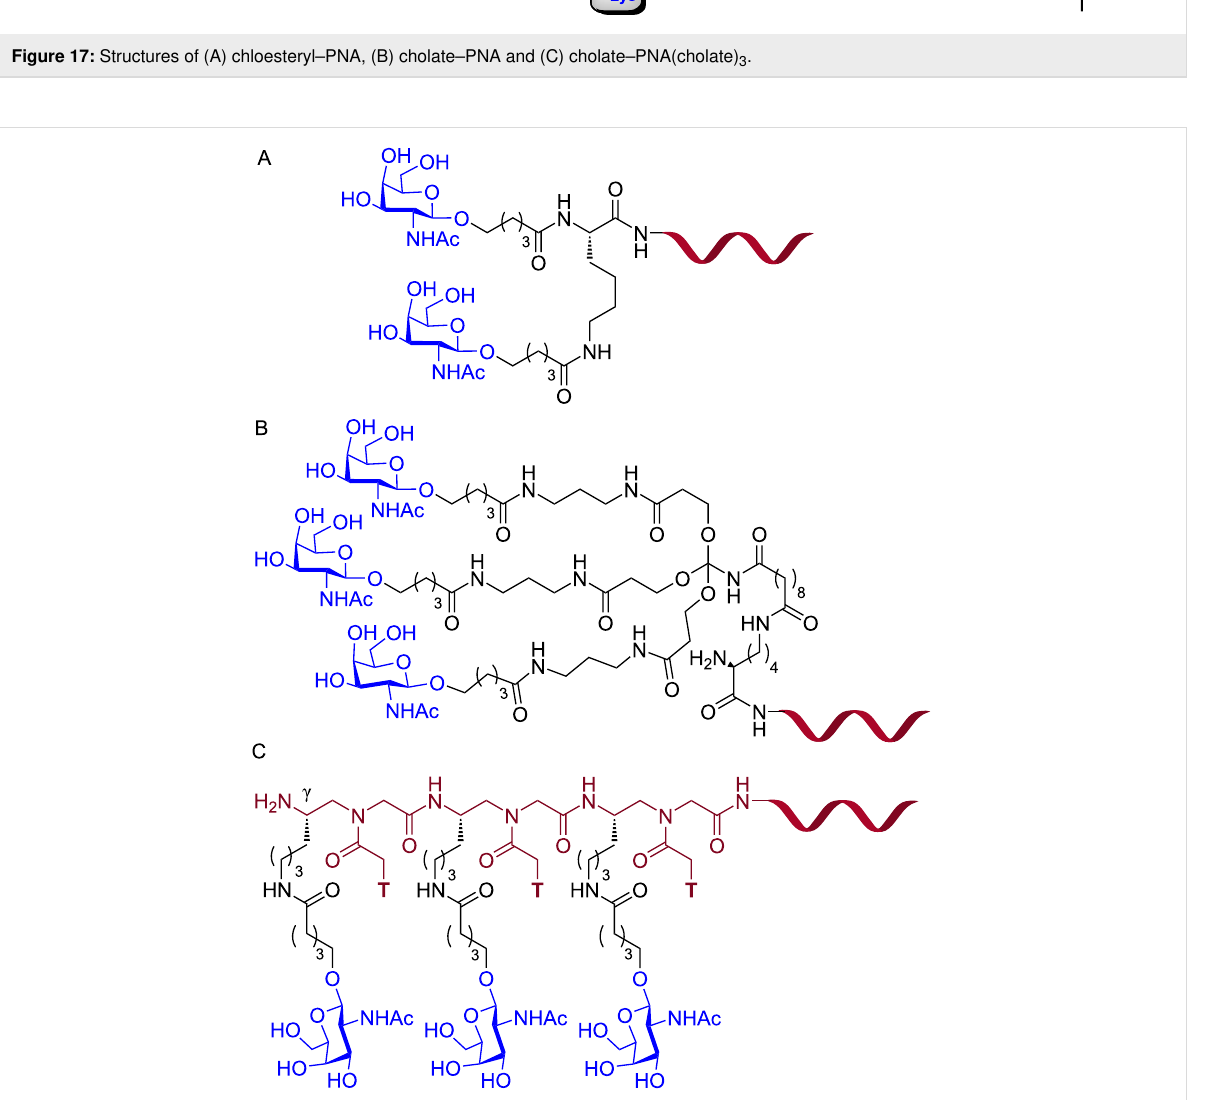
Figure 18: Structures of PNA–GalNAc conjugates (A) (GalNAc) 2 K, (B) triantennary (GalNAc) 3 , and (C) trivalent (T- γ -GalNAc) 3